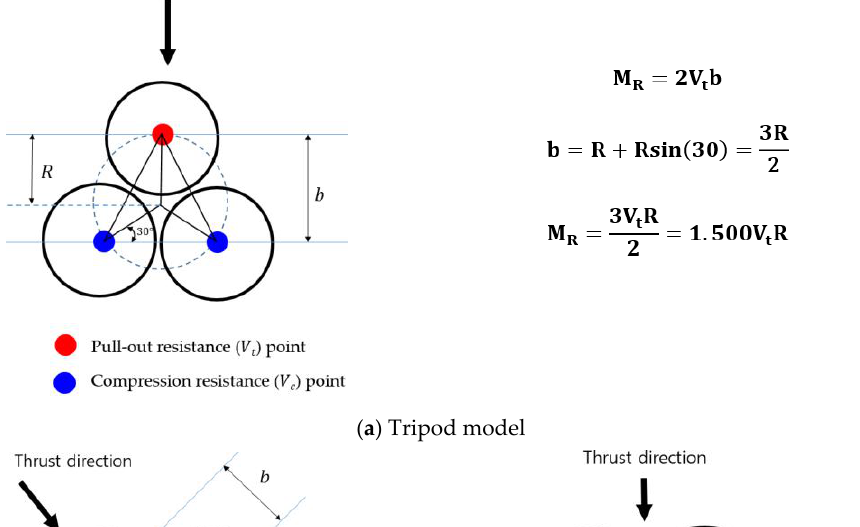
Table 1. Soil profile of survey site.